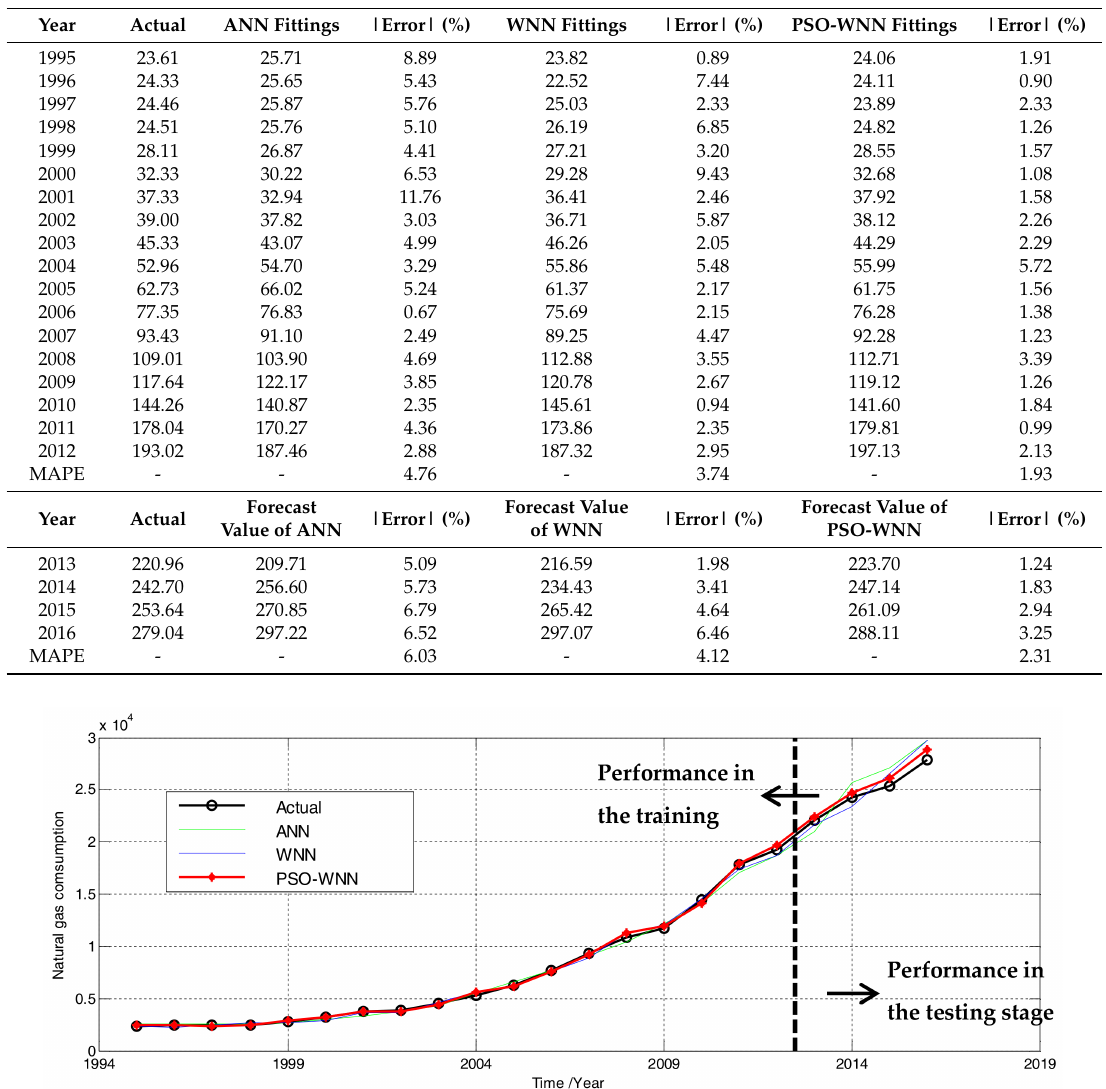
Figure 3. Performance of ANN, WNN and PSO-WNN